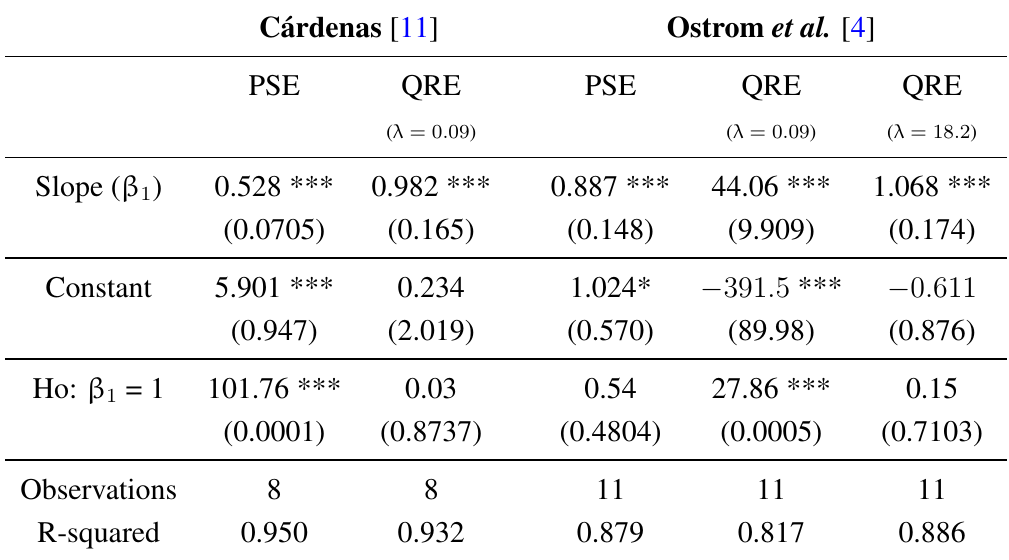
Table 3. OLS: observed versus predicted percentage